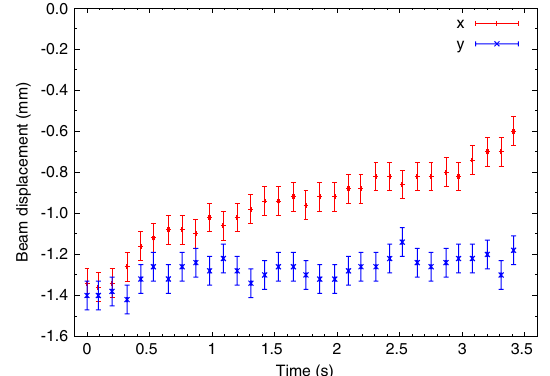
FIG. 7. Typical beam position data from the cavity BPM system, at a beam current of 280 pA. Each data point averages the position readings of ten resonance